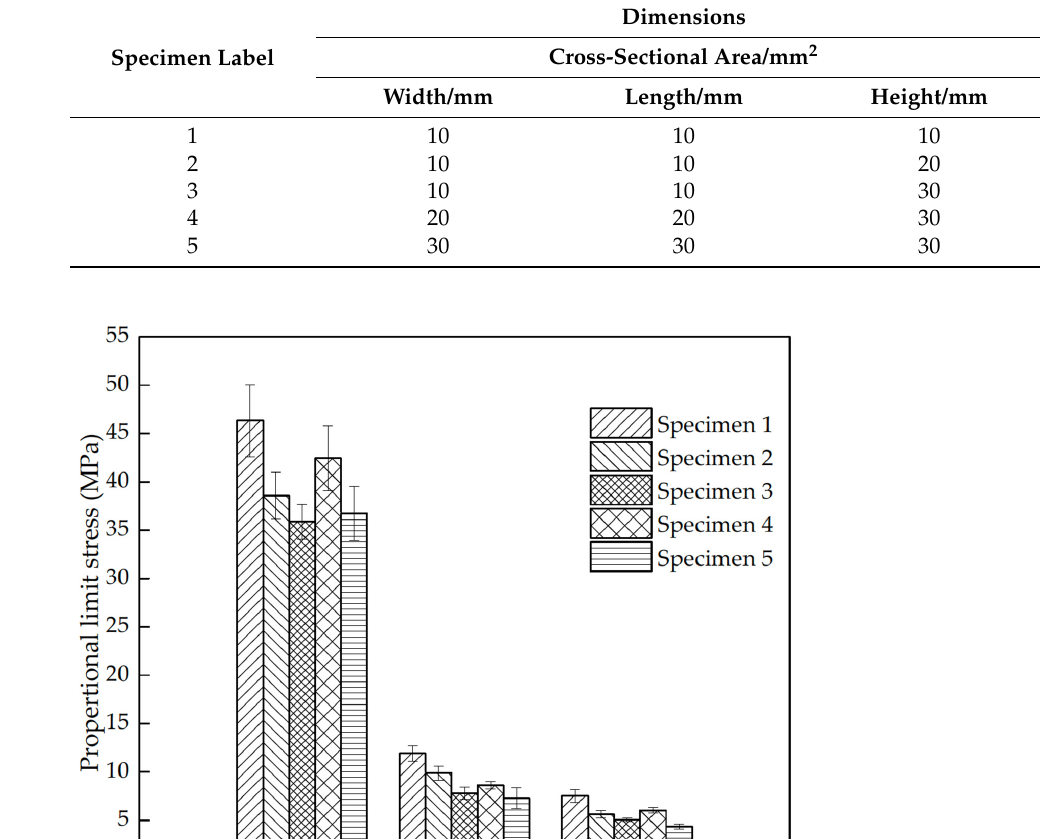
Figure 49. Proportional limit stresses for five different sizes of specimens of Fagus sylvatica cut in different orientations with respect to the trunk of the tree. From [134].